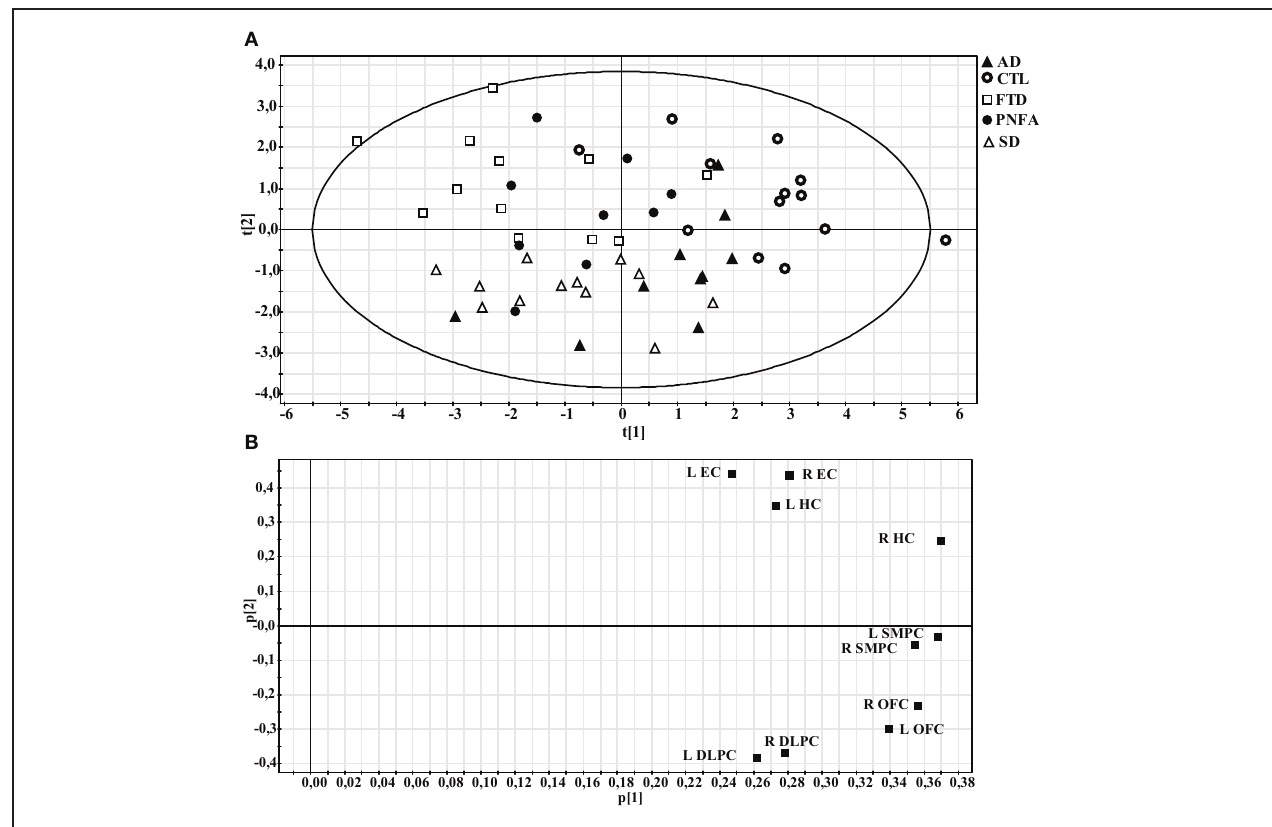
FIGURE 6 | Principal component analysis (PCA) of all subjects. (A) Scatter plot illustrating how individuals are distributed along the first two components. (B) Loading plot showing the influence of the regional volumes on the first two components.